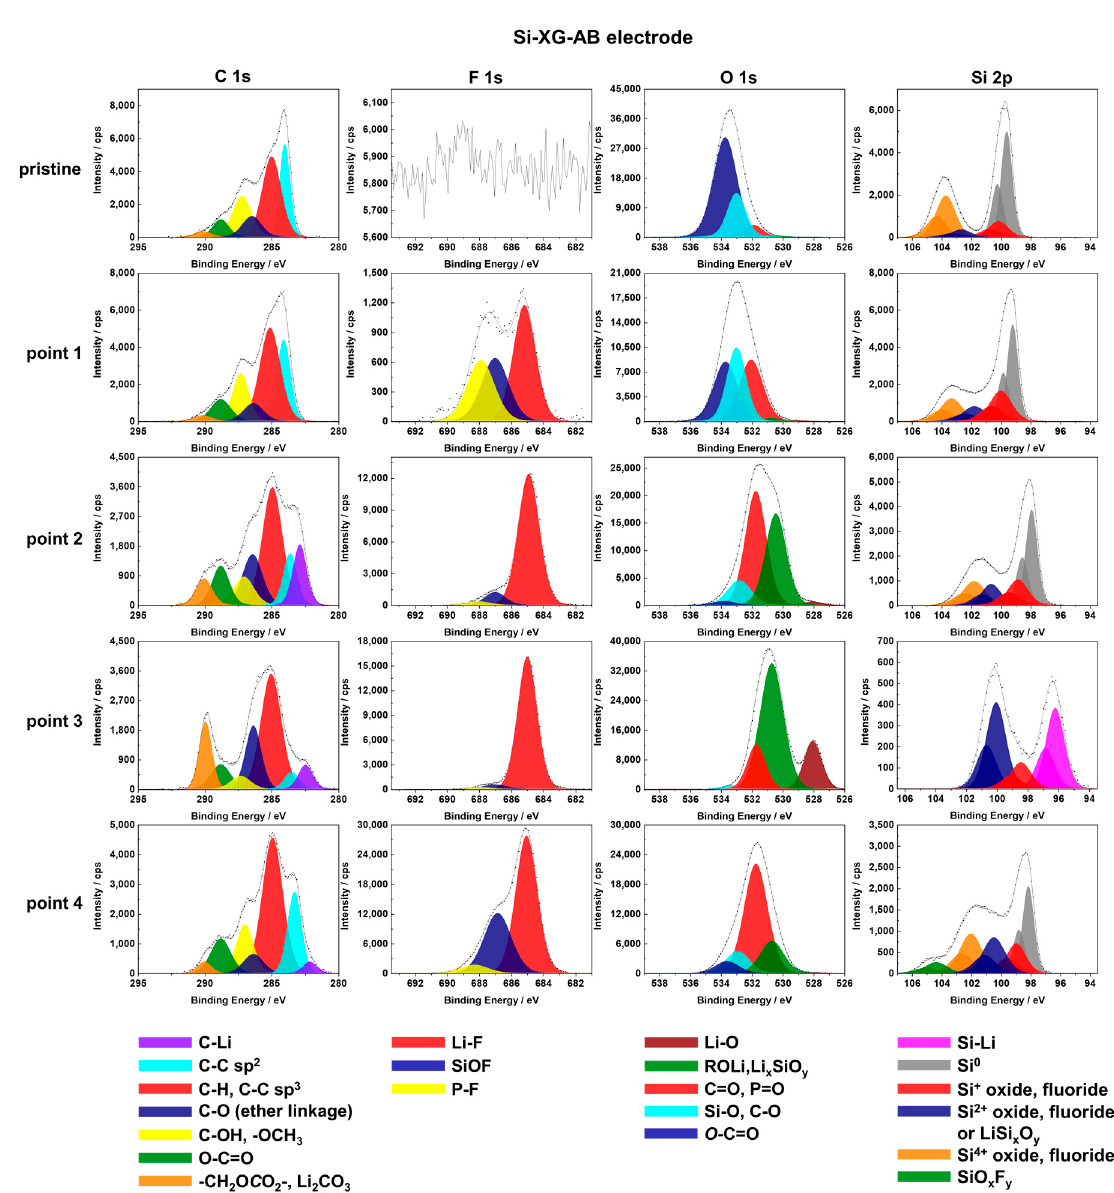
Figure 3. High-resolution C 1s, F 1s, O 1s, and Si 2p core level spectra obtained on the pristine surface of the Si-XG-AB electrode and the Si-XG-AB electrode after different stages of lithiation/delithiation (points 1–4) in 1 M LiPF 6 /DMC.